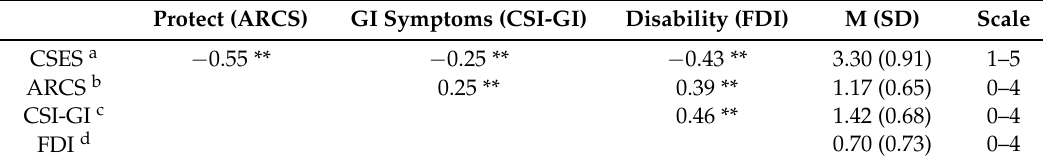
Table 1. Correlations among study variables and descriptive statistics ( n = 316). Protect (ARCS) GI Symptoms (CSI-GI)